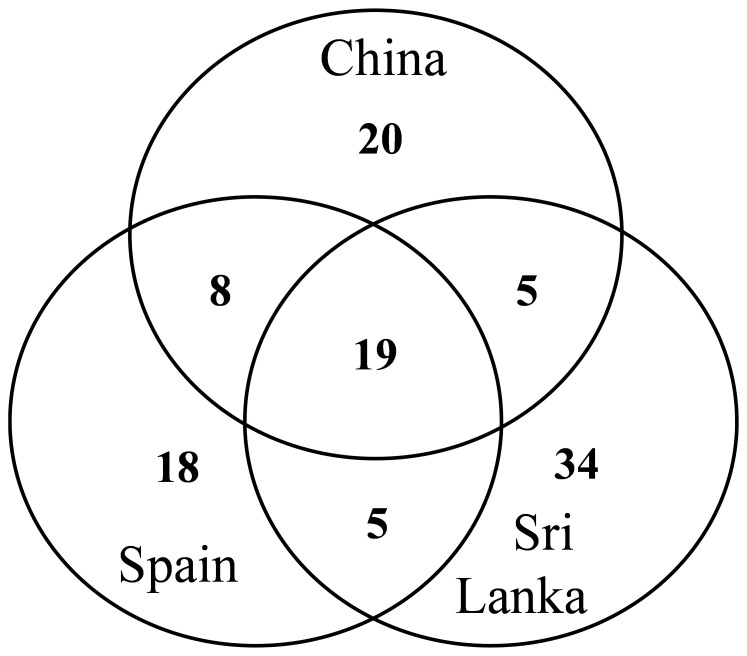
SSR alleles in the different origins.The figures indicate the number of SSR alleles private to each of the secondary centers of diversity, as well as the number of alleles shared by accessions from two or the three different origins.